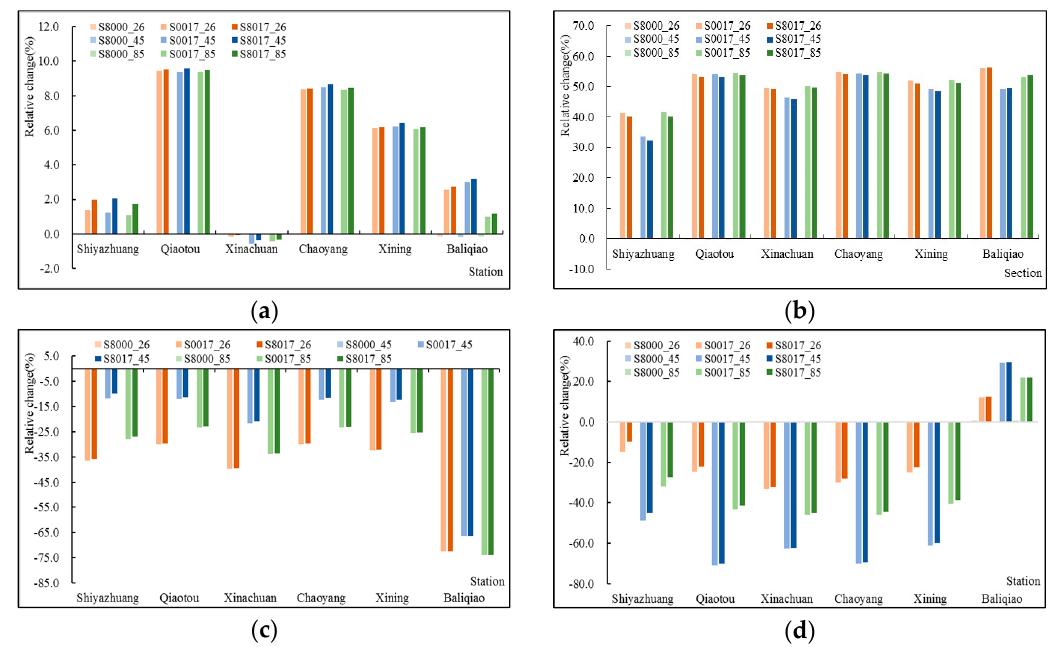
Figure 14. Relative change of ( a ) annual runoff, ( b ) runoff in wet season, ( c ) runoff in temperate